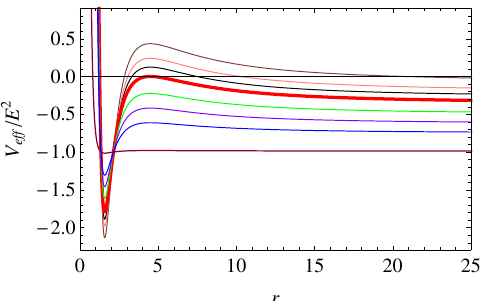
Figure 1. The effective potential for the EPYM AdS black h ole with the parameters γ = 1 . 01 , P = 0 . 003 , q = 1 . 9 , M = 2. The angular momentums L/E of the photon varies from 0 . 5 to 36 from bottom to